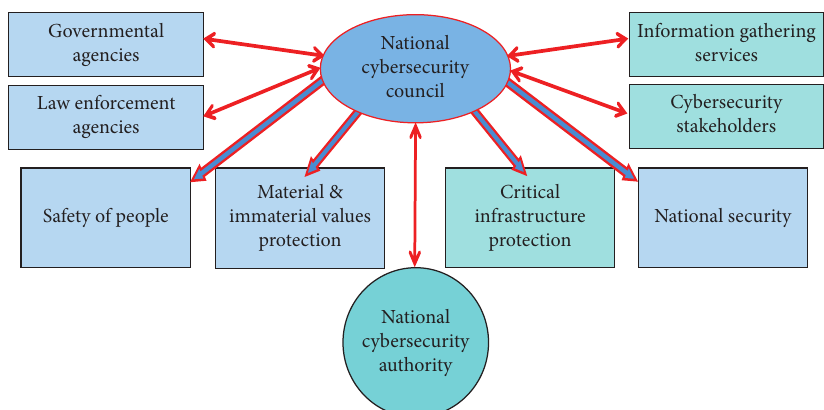
Figure 10: ITU National Cyber Security Coordination Council